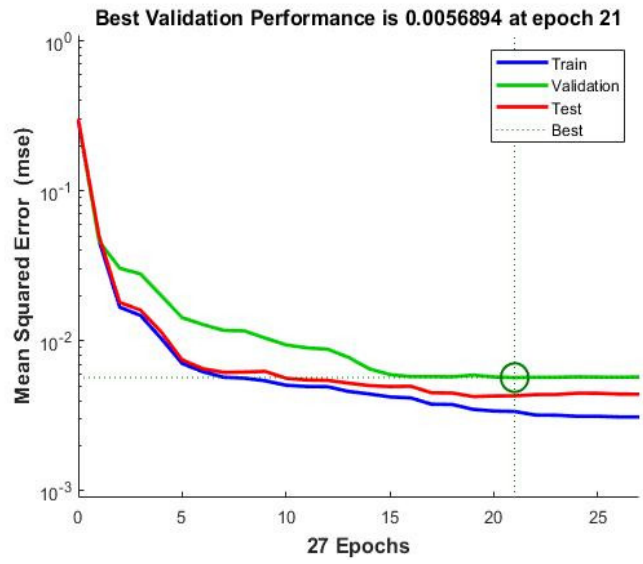
Figure 2. Performance graphic of the best ANN model.